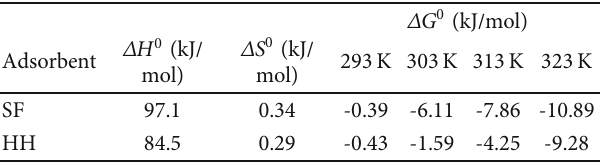
Figure 7: Isotherms of Pb 2+ adsorption on HH and SF at pH 4 and their statistical physics modeling. Table 4: Thermodynamic parameters for the Pb 2+ adsorption on SF and HH at pH